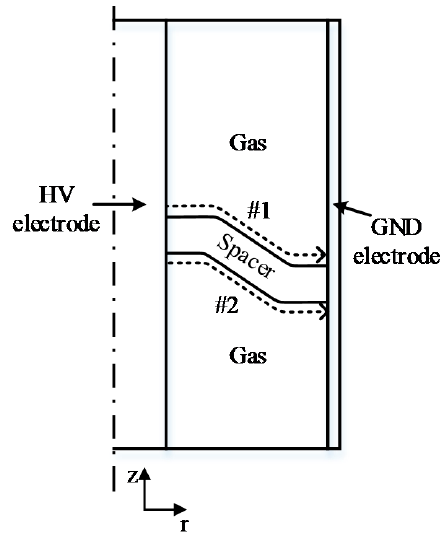
Figure 5. Simulation model for cone spacer.